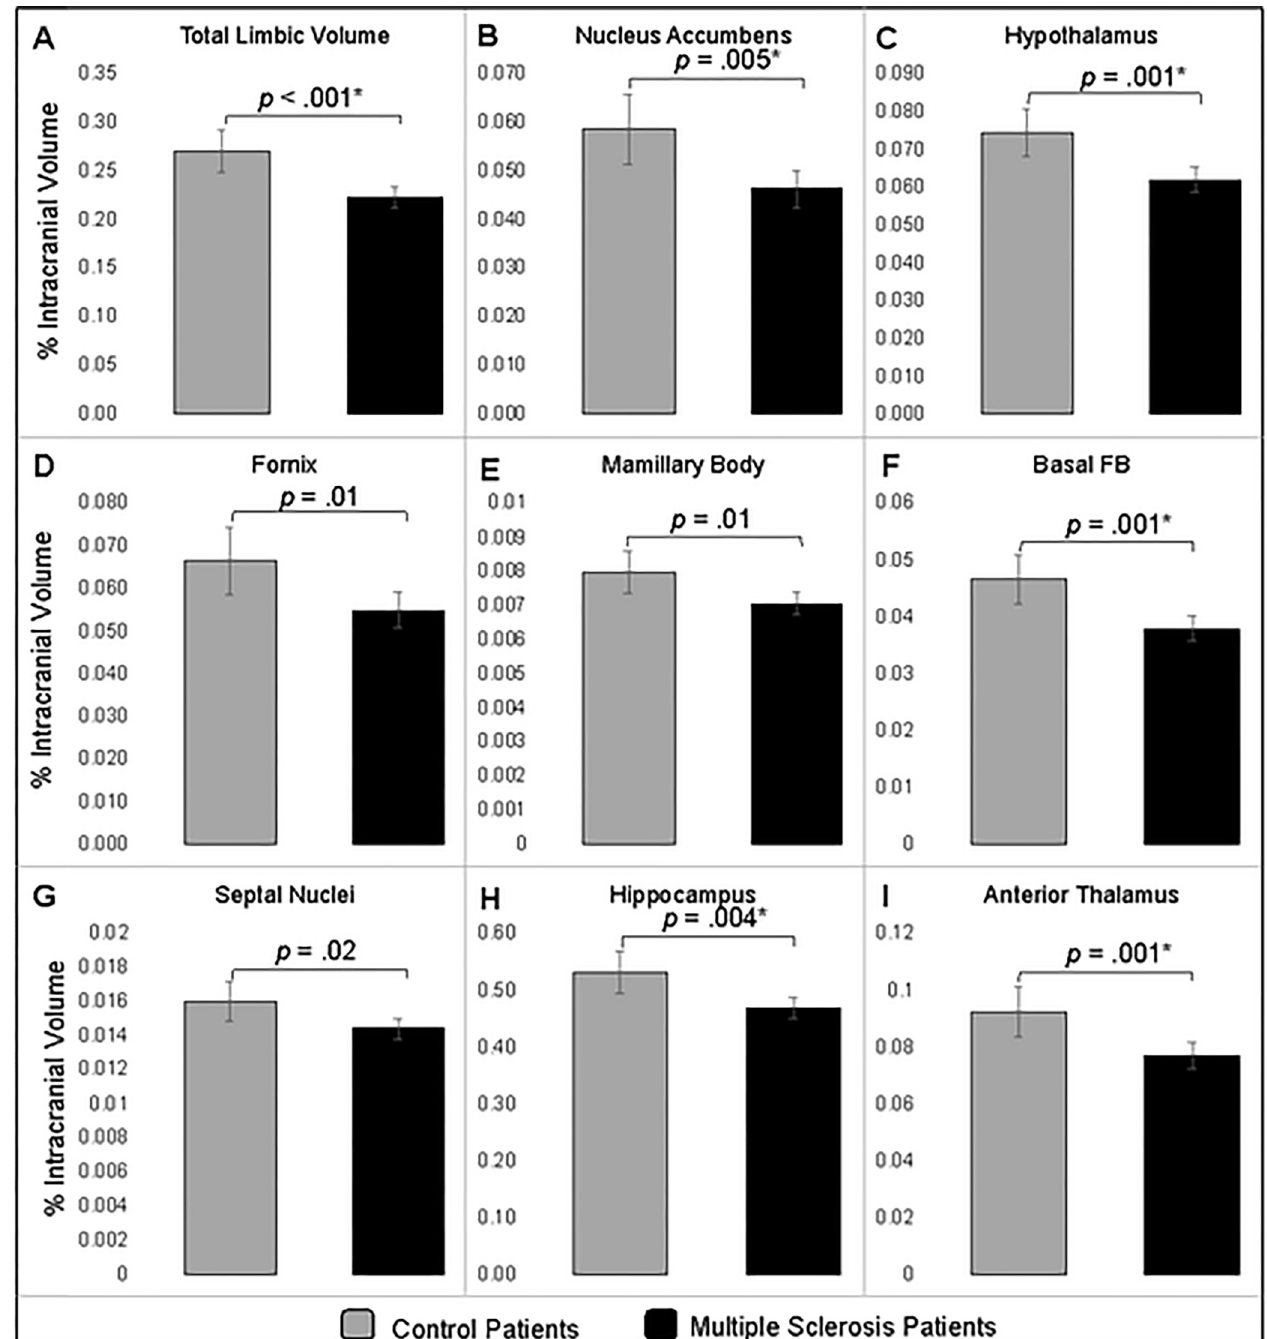
Fig 1. Comparison of limbic region volume between MS and control patients. The mean (95% CI) percentage of total intracranial volume occupied by limbic nuclei that were significantly different between the groups. ANCOVA analyses adjusted for patient race, age, sex, and BMI. The p -value for each comparison are presented and an asterisk ( � ) indicates the comparison remained statistically significant following application of the Bonferroni correction.